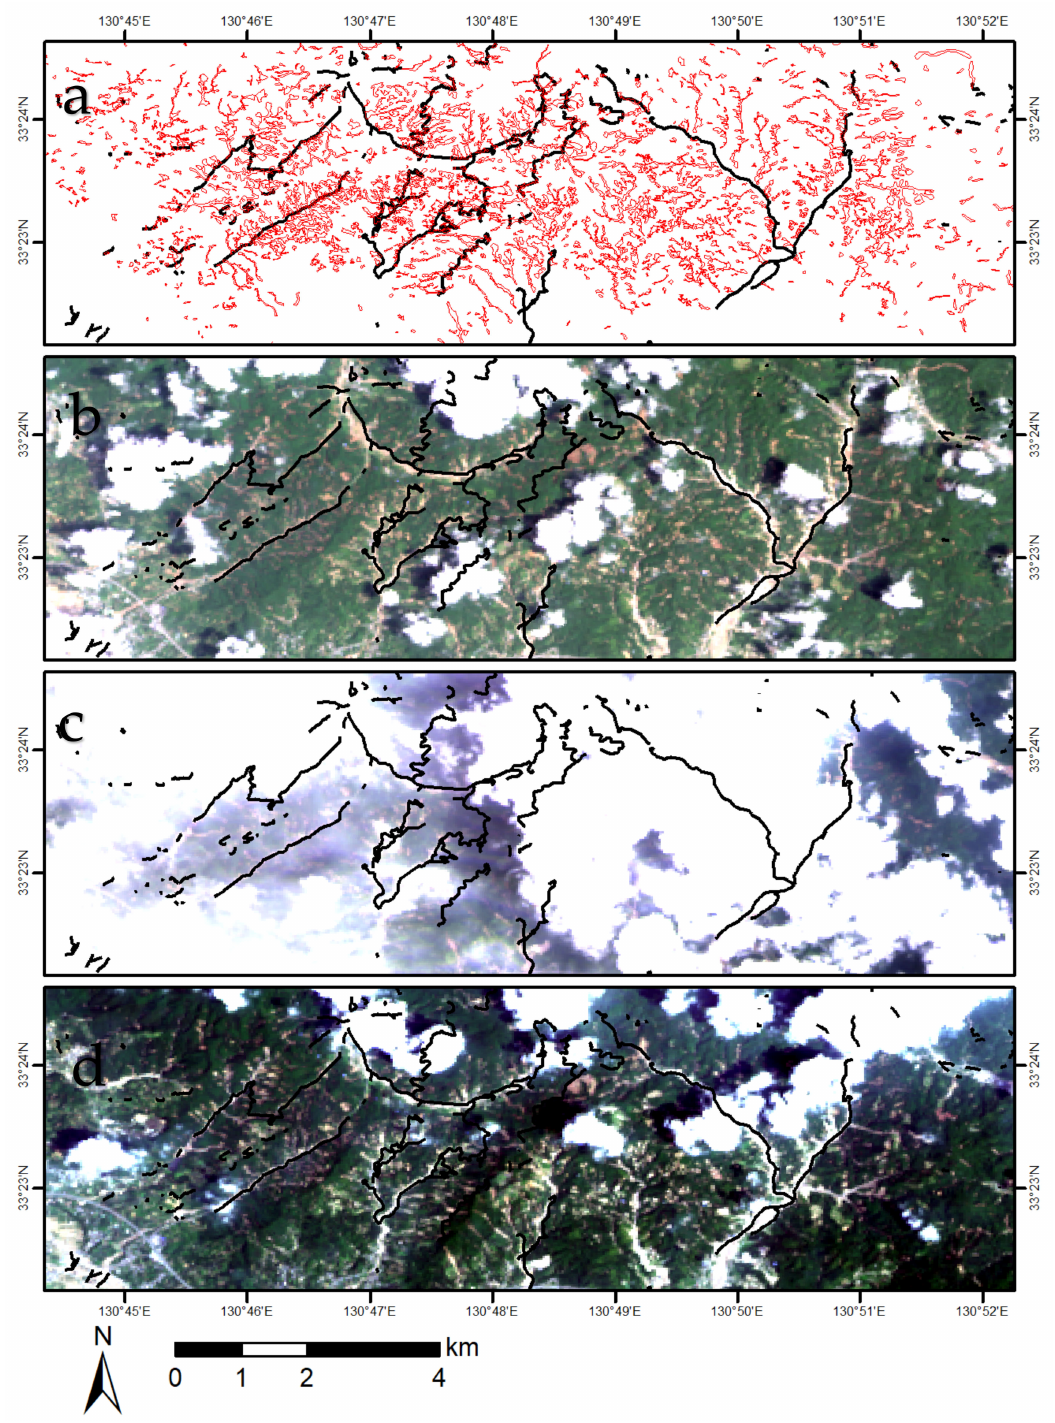
Figure 10. Landsat-8 OLI true-color composite images acquired in the month of July 2017 after the torrential rain event. The extent of the images corresponds to the white line boxed region in Figure 5. The landslide areas are shown as red polygons in ( a ) and the damaged roads are shown as black lines in ( a – d ) for reference (the GSI, https: // www.gsi.go.jp / common / 000194860.zip). The map was created with ArcGIS ® software (ArcMap ™ 10.6.1, Esri, Redlands, CA, USA, http: //